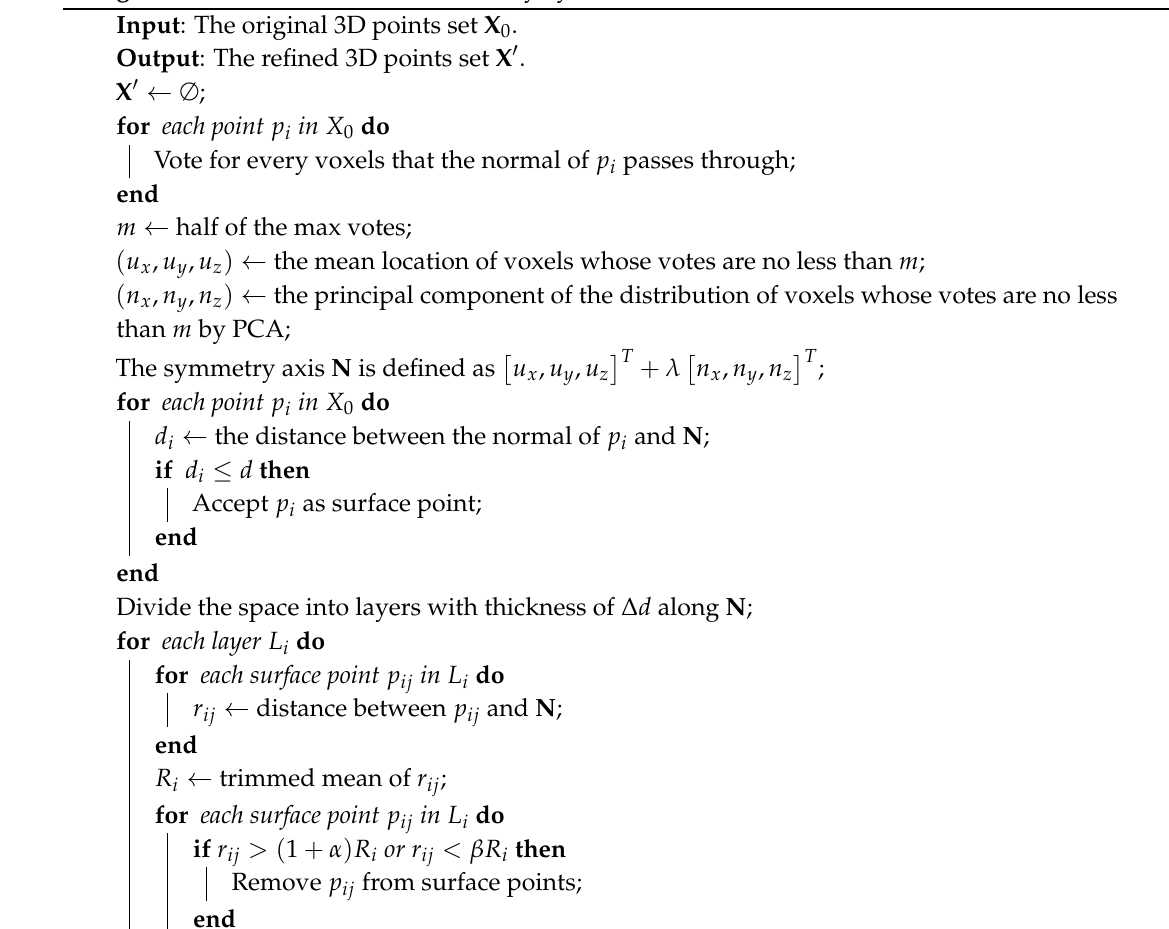
Algorithm 2: Refinement for rotationally-symmetric